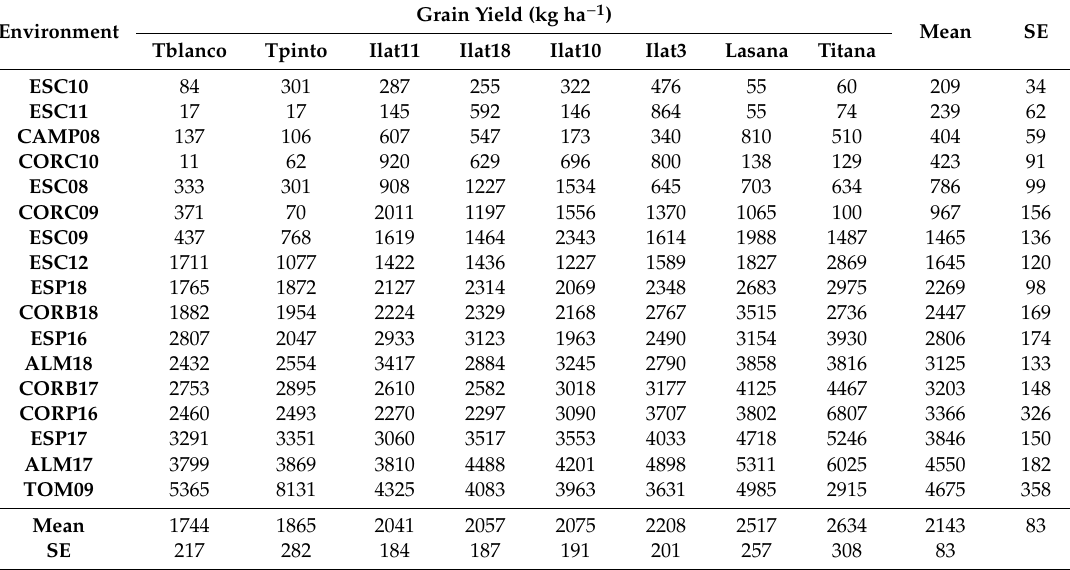
Table 3. Mean grain yield (kg ha − 1 ) of 8 grass pea accessions grown at 17 location–year.